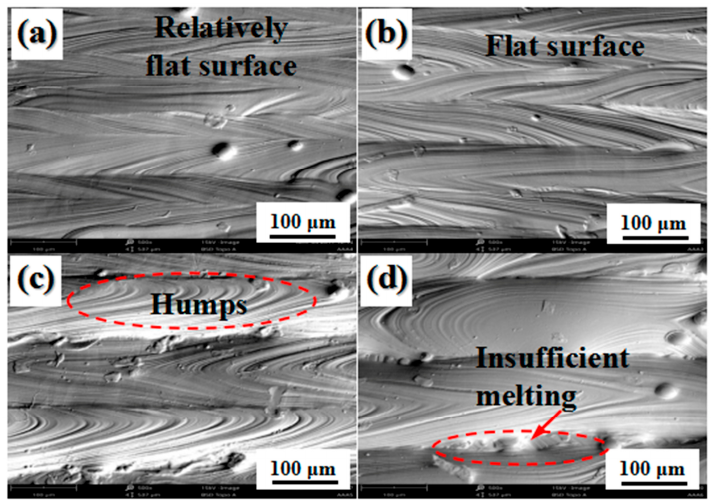
Figure 9. Morphology of the top surface of SLM-processed 316L SS parts for different hatch spacings: ( a ) H = 75 µ m, ( b ) H = 100 µ m, ( c ) H = 150 µ m, and ( d ) H = 200 µ